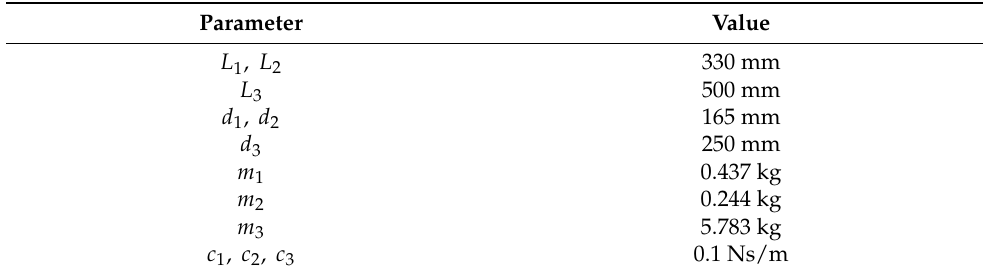
Table 3. Input parameters for dynamic model simulation.